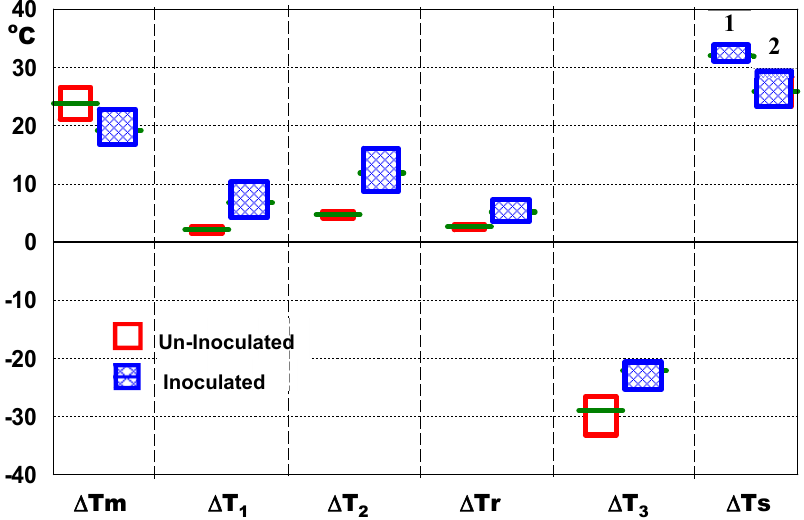
Figure 5. Solidification undercooling degree of un-and-inoculated grey cast irons referring to stable (ΔTm) and metastable (ΔT 1 , ΔT 2 , ΔT 3 ) eutectic temperatures, and eutectic recalescence (ΔTr) of the experimental heats (ΔTs: ( 1 ) calculated; ( 2 ) measured).